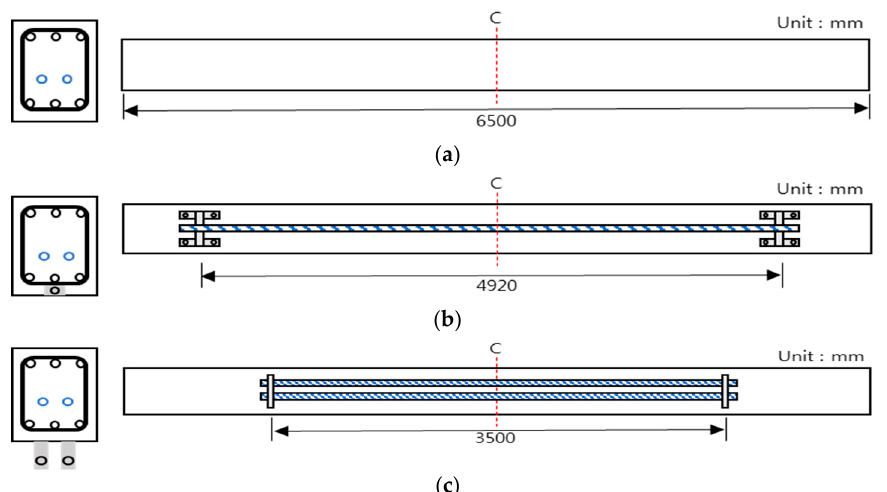
Figure 3. Specimen strengthening methods: ( a ) control, ( b ) near surface mounted (NSM), and ( c ) external prestressing (EP).